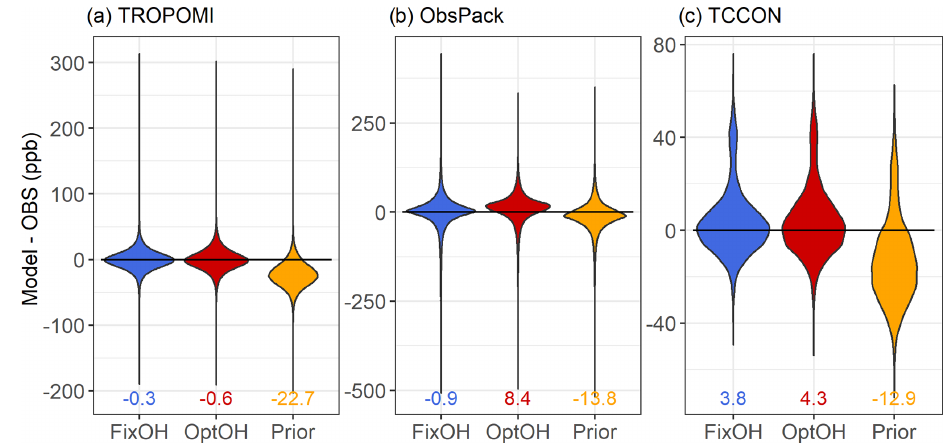
Figure 3. Evaluation of the prior and optimized methane simulations (May 2018–October 2019) against (a) TROPOMI XCH 4 observations, (b) ObsPack in situ methane measurements, and (c) TCCON ground-based methane column observations. Numbers inset indicate the mean model-observation bias (unit: